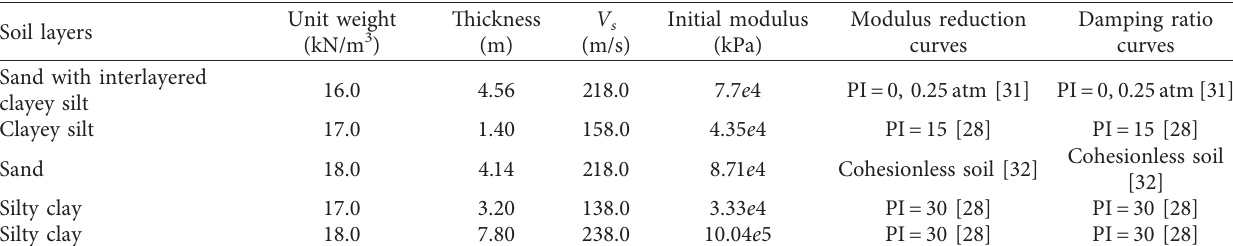
Damping ratio curves